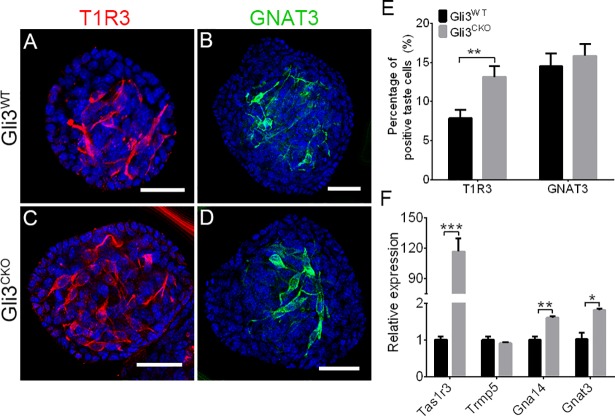
Gli3 deficiency affects taste cell differentiation and expression of Shh target genes.(A-D) Indirect immunofluorescence confocal microscopy of taste organoids cultured from individual FACS-sorted Lgr5-GFP cells isolated from CV papillae of double-knockin mice treated with tamoxifen (Gli3CKO; C, D) or without (Gli3WT;A, B) and stained with antibodies against T1R3 (A, C) or GNAT3 (B, D). Scale bars, 100 μm. (E) The number of T1R3+ (n = 76, t = 3.05, p<0.01) but not GNAT3+ (n = 84, t = 0.61, p>0.05) cells increased in Gli3CKO organoids. (F) In Gli3CKO organoids vs. those from Gli3WT the expression of Tas1r3 mRNA (t = 8.87, p<0.001) increased dramatically, while that of Gna14(t =, p<0.01) and Gnat3 (t = 4.37, p<0.05) showed a modest increase, but that of Trpm5 (t = 1.17, p>0.05) remained unchanged. Data are means + SEM. *p<0.05, **p<0.01, ***p<0.001.